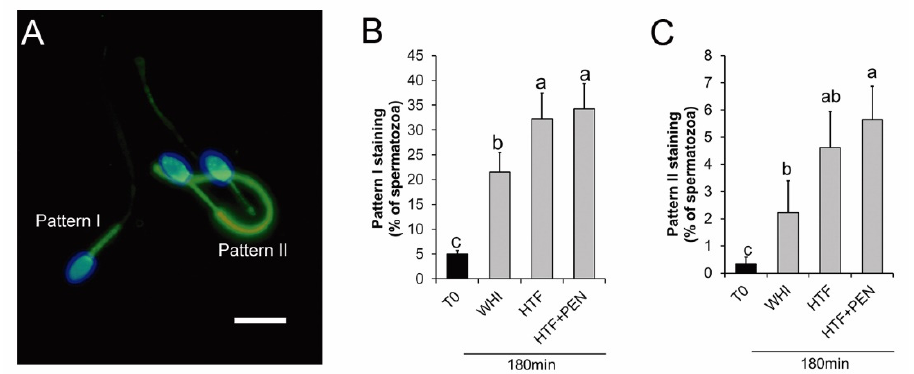
Figure 3. Protein tyrosine phosphorylation in stallion spermatozoa after 180 min of incubation for capacitation. ( A ) Micrograph of fluorescence microscopy of stallion spermatozoa after 180 min of capacitation and immune-labelled for protein tyrosine phosphorylation (PTP) (green). Nuclei were labelled with Hoechst 33342 (blue), bar = 10 µm. Pattern I: spermatozoa showing PTP at the midpiece. Pattern II: Spermatozoa showing PTP along the whole flagellum. ( B , C ) Percentage of spermatozoa showing pattern I (B) and pattern II ( C ) staining at time 0 and after 180 min of incubation in Whitten’s medium (WHI), synthetic human tubal fluid (HTF), or HTF supplemented with 750 µM of penicillamine (HTF + PEN). a, b, c Different letters indicate significant differences ( p < 0.05, n = 6, 12 determinations).